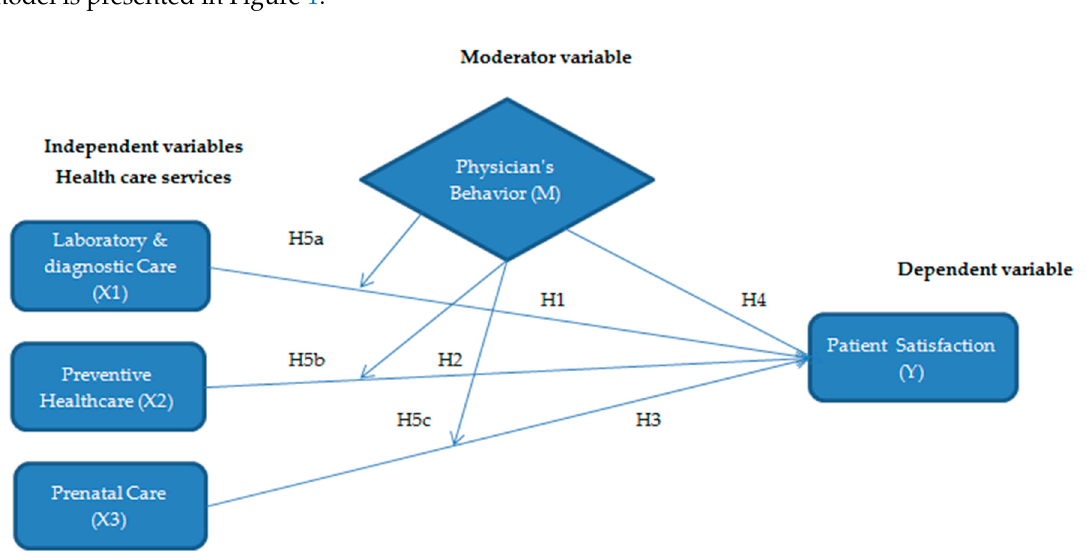
Figure 1. Conceptual (Hypothesized) model.